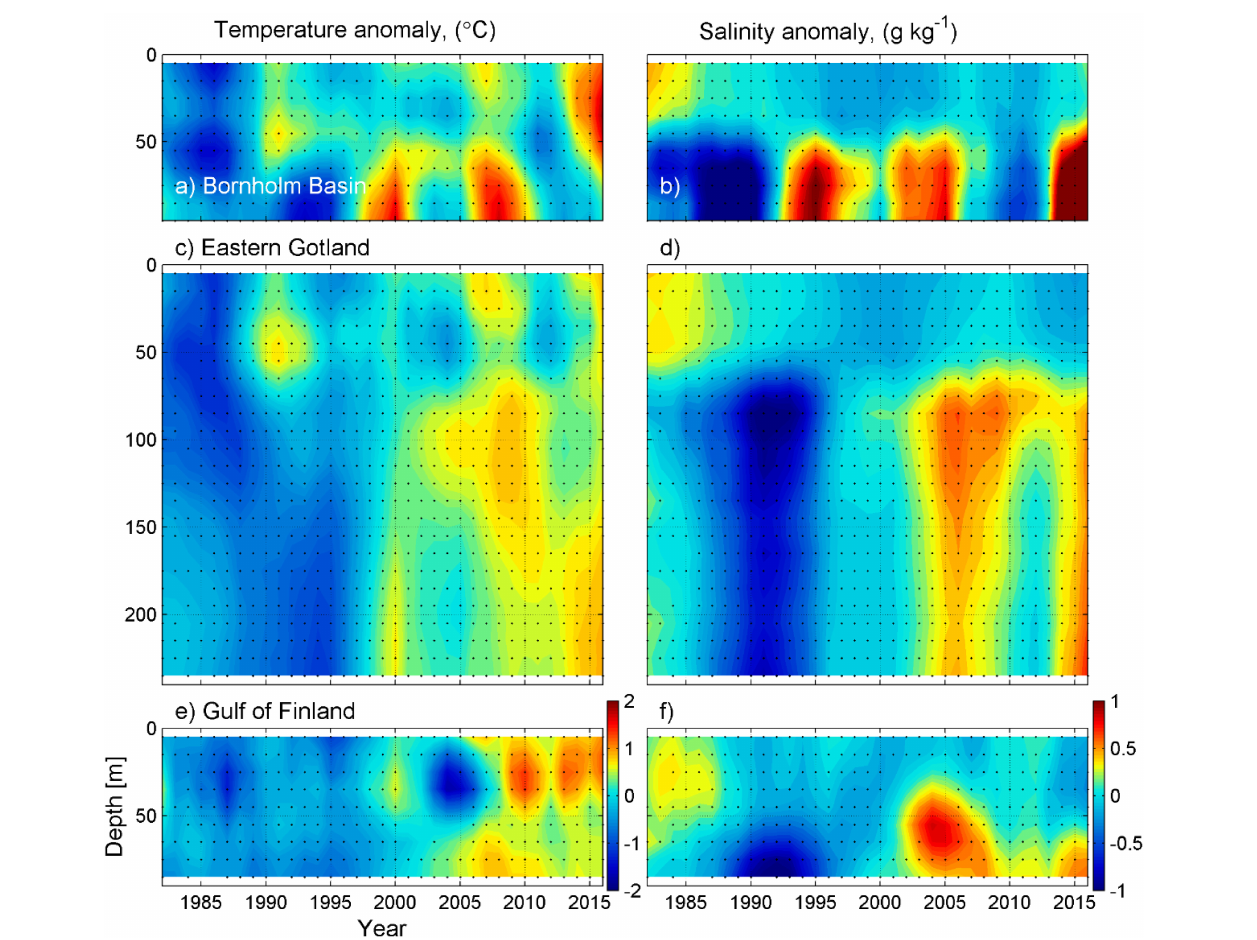
FIGURE 7 | Time-series of annual anomalies of temperature (A,C,E) and salinity (B,D,F) in the Bornholm Basin, the Eastern Gotland Basin, and the Gulf of